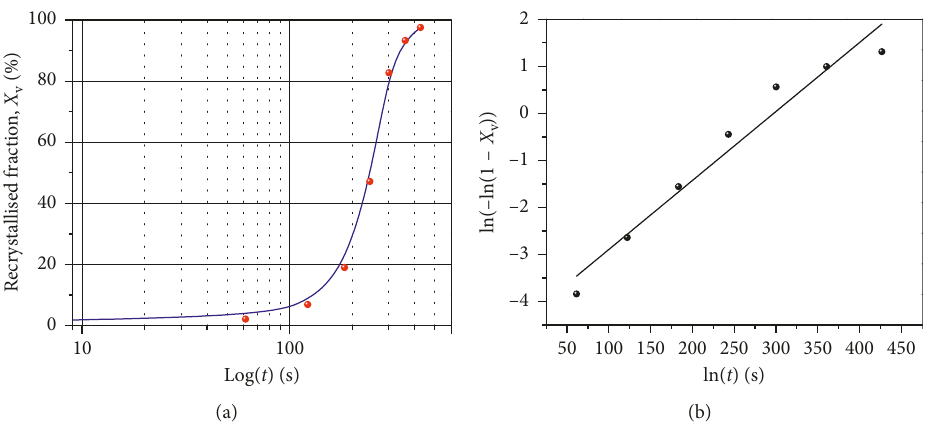
Figure 4: (a) Effect of recrystallisation kinetics for different isothermal annealing times of IF steel at 780 ° C, with 90% reduction, and (b) JMAK plot recrystallisation kinetics of IF steel at 780 ° C, with 90% reduction.